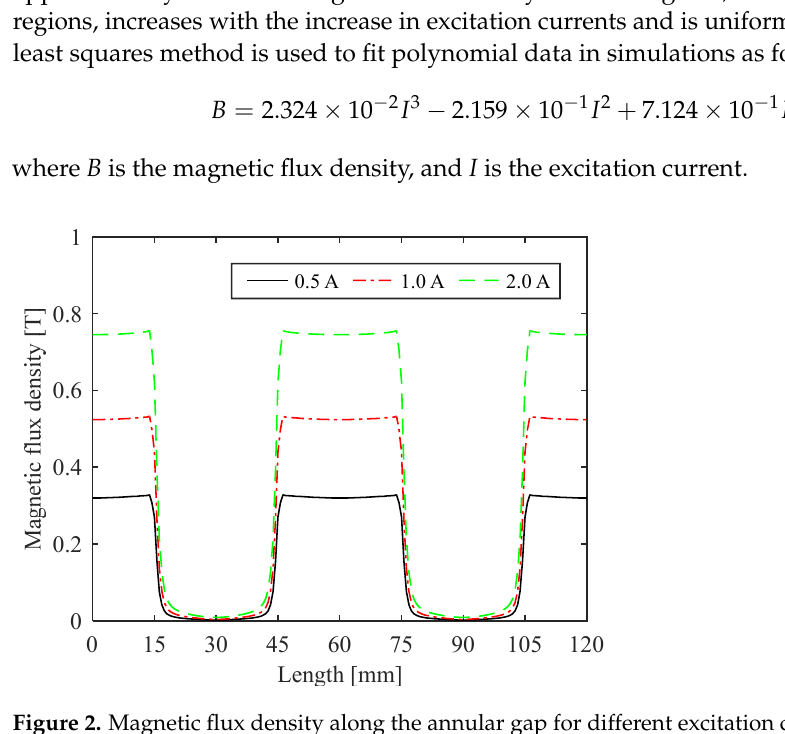
Figure 2. Magnetic flux density along the annular gap for different excitation currents.